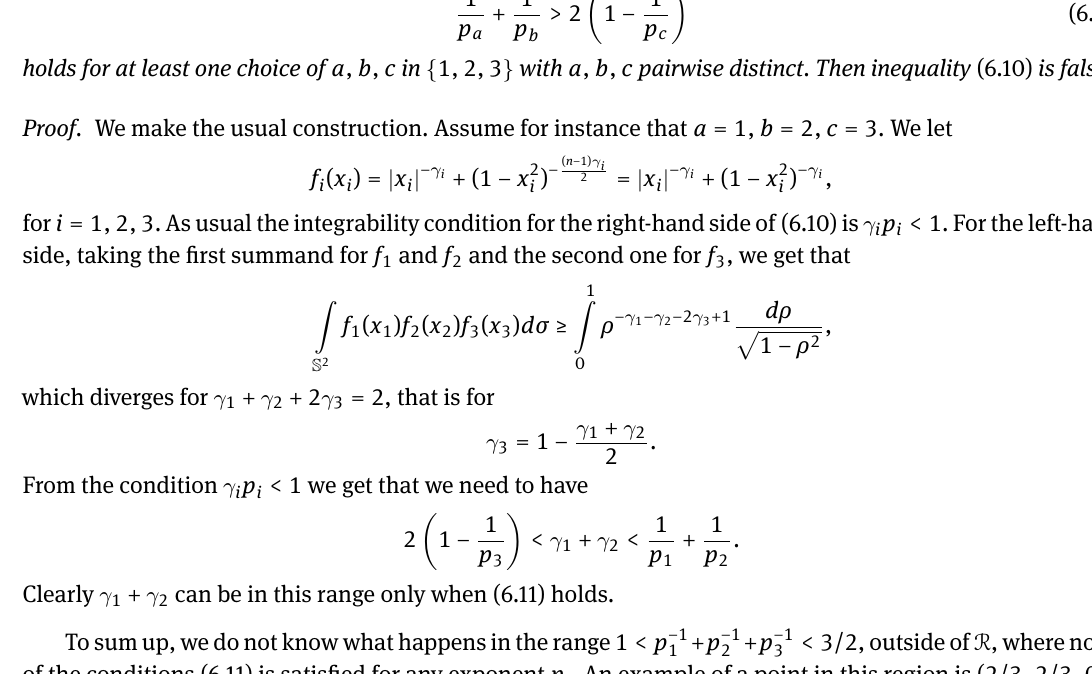
The only points left are those outside of R for which 1 < p −1 following proposition which leads to a partial improvement towards the